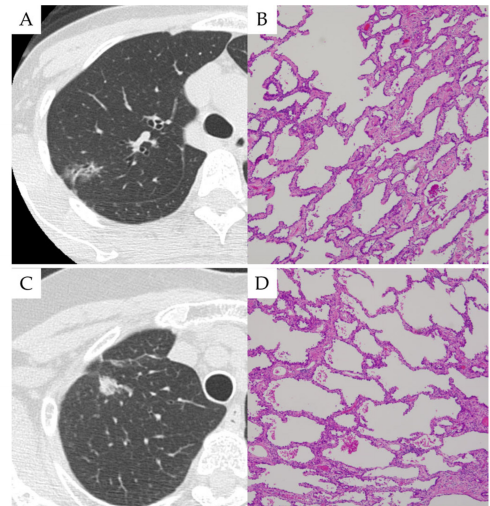
Figure 7. Two cases that showed no dispersed tumor DNA detection. ( A , B ) CT image and histology of case 1. ( C , D ) CT image and histology of case